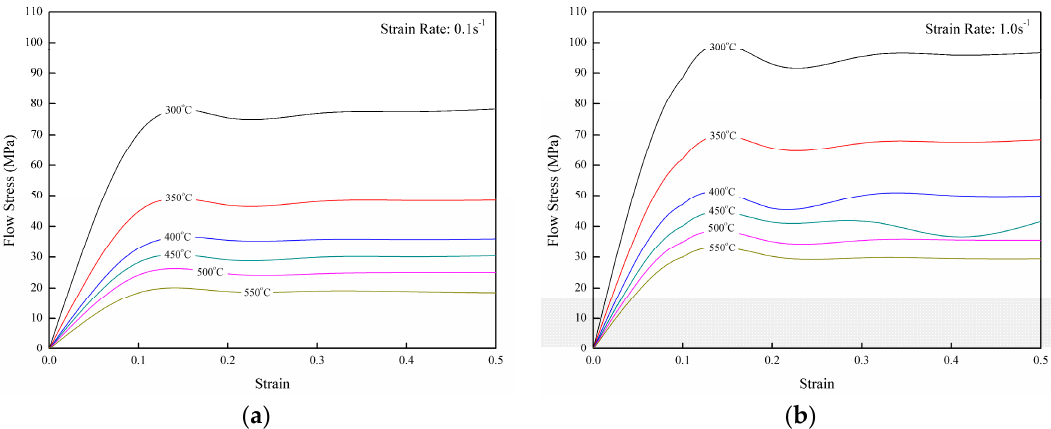
Figure 3. Flow stress–strain curve of homogenized composite 6061-Al 2 O 3 at strain rate ( a ) 0.1 s − 1 and ( b ) 1.0 s − 1 .